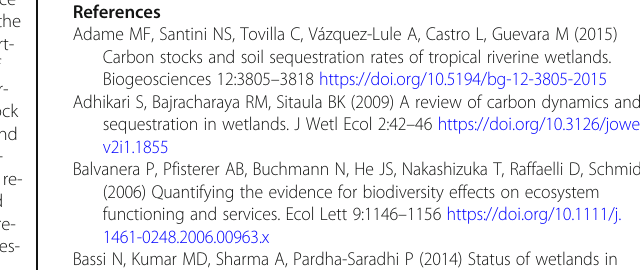
Additional file 1: Table S1 . Distribution and density (no. of individuals ha -1 ) of vegetation across various sampling stations of the wetland and Kruskal-Wallis test with habitat conditions under different sampling sta- tions as the main effect variable; Table S2 . One-way analyses of variance for micro-topography, water flow regime and vegetation attributes in the wetland with flood phases as the main effect variable; Table S3 . Import- ance Value Index (IVI) of vegetation across various sampling stations of the wetland and Kruskal-Wallis test with habitat conditions under differ- ent sampling stations as the main effect variable; Table S4 . Carbon stock (Mg ha -1 ) of vegetation in different sampling stations of the wetland and Kruskal-Wallis test with habitat conditions under different sampling sta- tions as the main effect variable; Table S5 . Detailed results of multiple re- gression analysis (using backward method) for carbon stock in wetland vegetation against the micro-topographic parameters and water flow re- gime of the wetland; Table S6 . Excluded variables in the multiple regres- sion analysis (using backward method) for carbon stock in